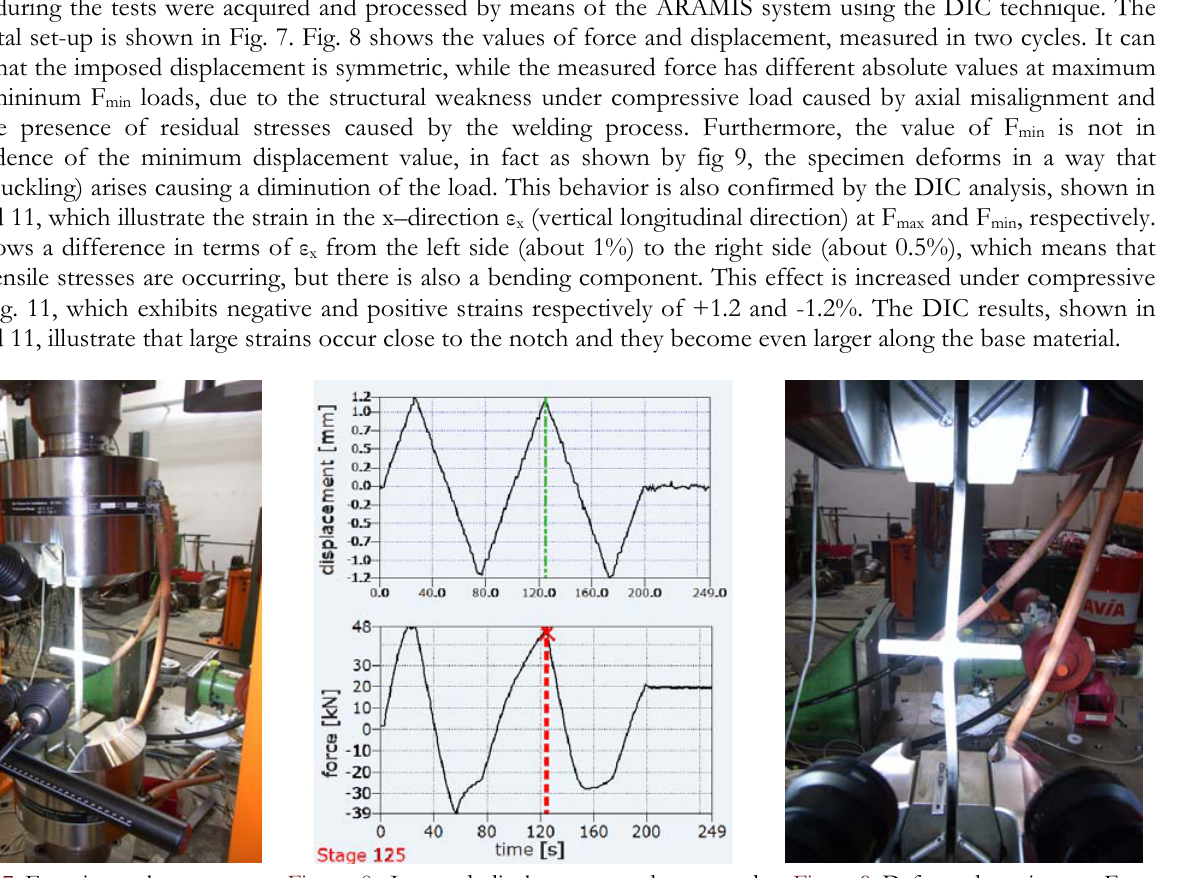
Figure 7: Experimental setup. Figure 8: Imposed displacement and measured force.